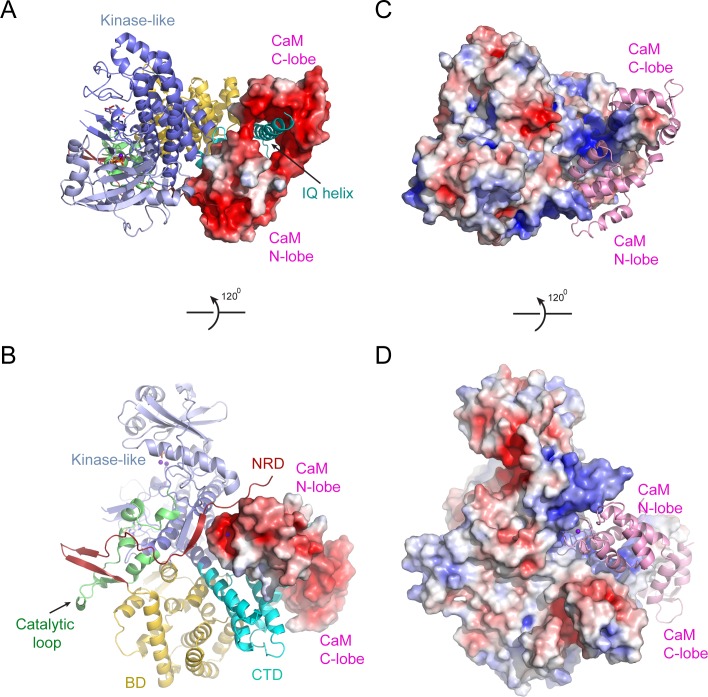
Electrostatic surface potential analysis of the interaction between SidJ and CaM.(A) The SidJ–CaM complex with SidJ depicted in ribbon and CaM shown with a surface representation colored by electrostatic surface potential, with red being negatively charged with −5 eV and blue being positively charged with +5 eV. (B) A 120° rotated view of the structure in panel (A). CaM is highly negatively charged as shown from both views. (C) The SidJ–CaM complex with SidJ presented on the surface, which is colored according to its electrostatic surface potential (red: −5 eV; blue: +5 eV), with CaM in ribbon. (D) A 120° rotated view of the structure in panel (C). The regions of SidJ interfaced with CaM are significant positively charged as shown from both views.